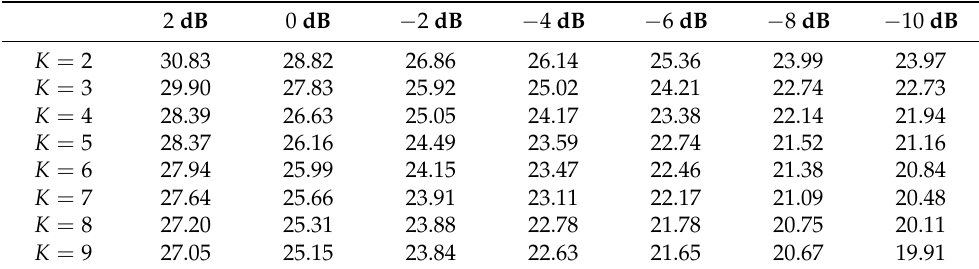
Figure 6. 2D frequency spectrum: ( a ) 2D frequency spectrum of the original signal and ( b ) 2D frequency spectrum of the noisy signal, where signal-to-noise ratio (SNR) is − 2 dB. Table 2. Peak signal noise rate (PSNR) with different K .